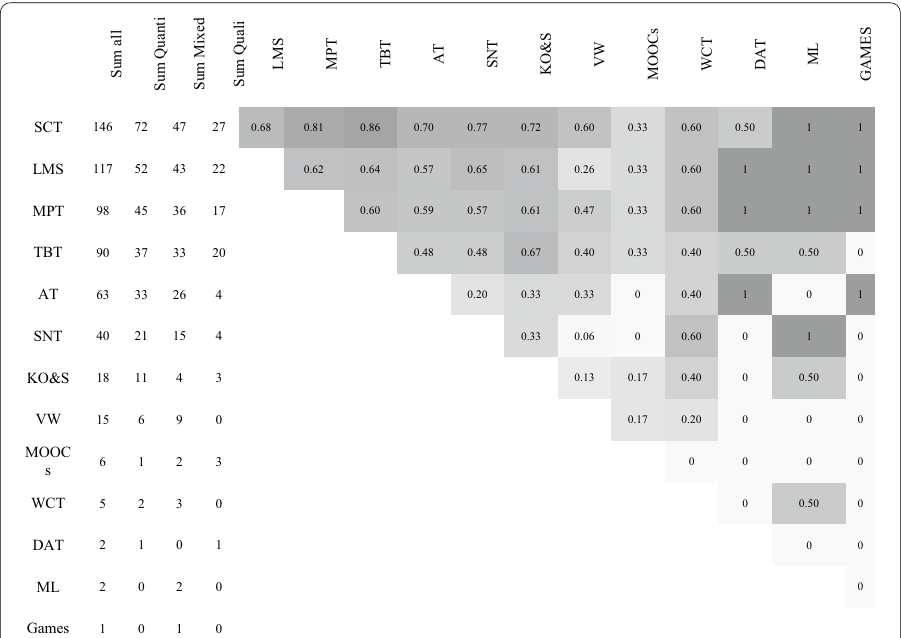
282). Note: Quanti = learning management system, MPT = assessment tools, SNT social networking tools, KO&S = = virtual worlds, WCT website creation tools, DAT = =